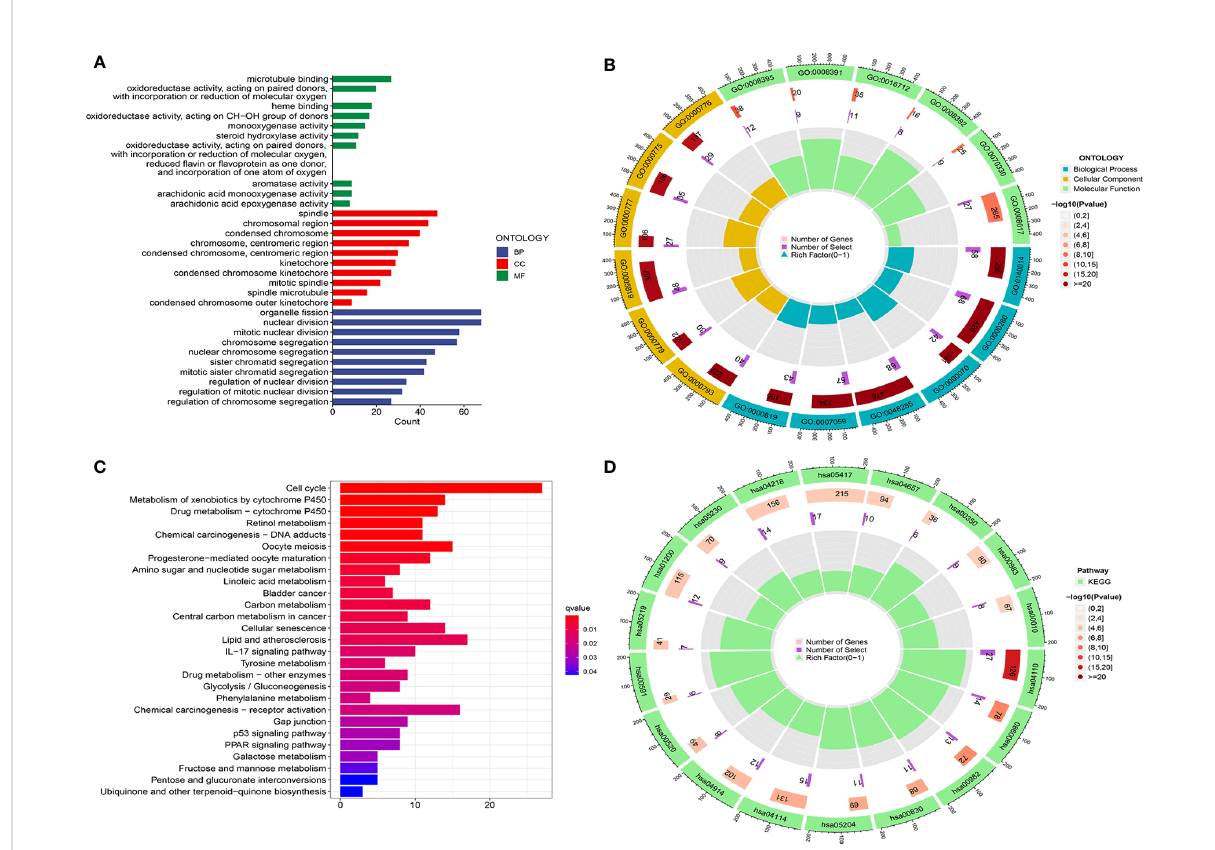
FIGURE 6 Analysis of functional enrichment. (A, B) GO analysis using a bar diagram and chordal graph. (C, D) KEGG analysis using a bar diagram and chordal